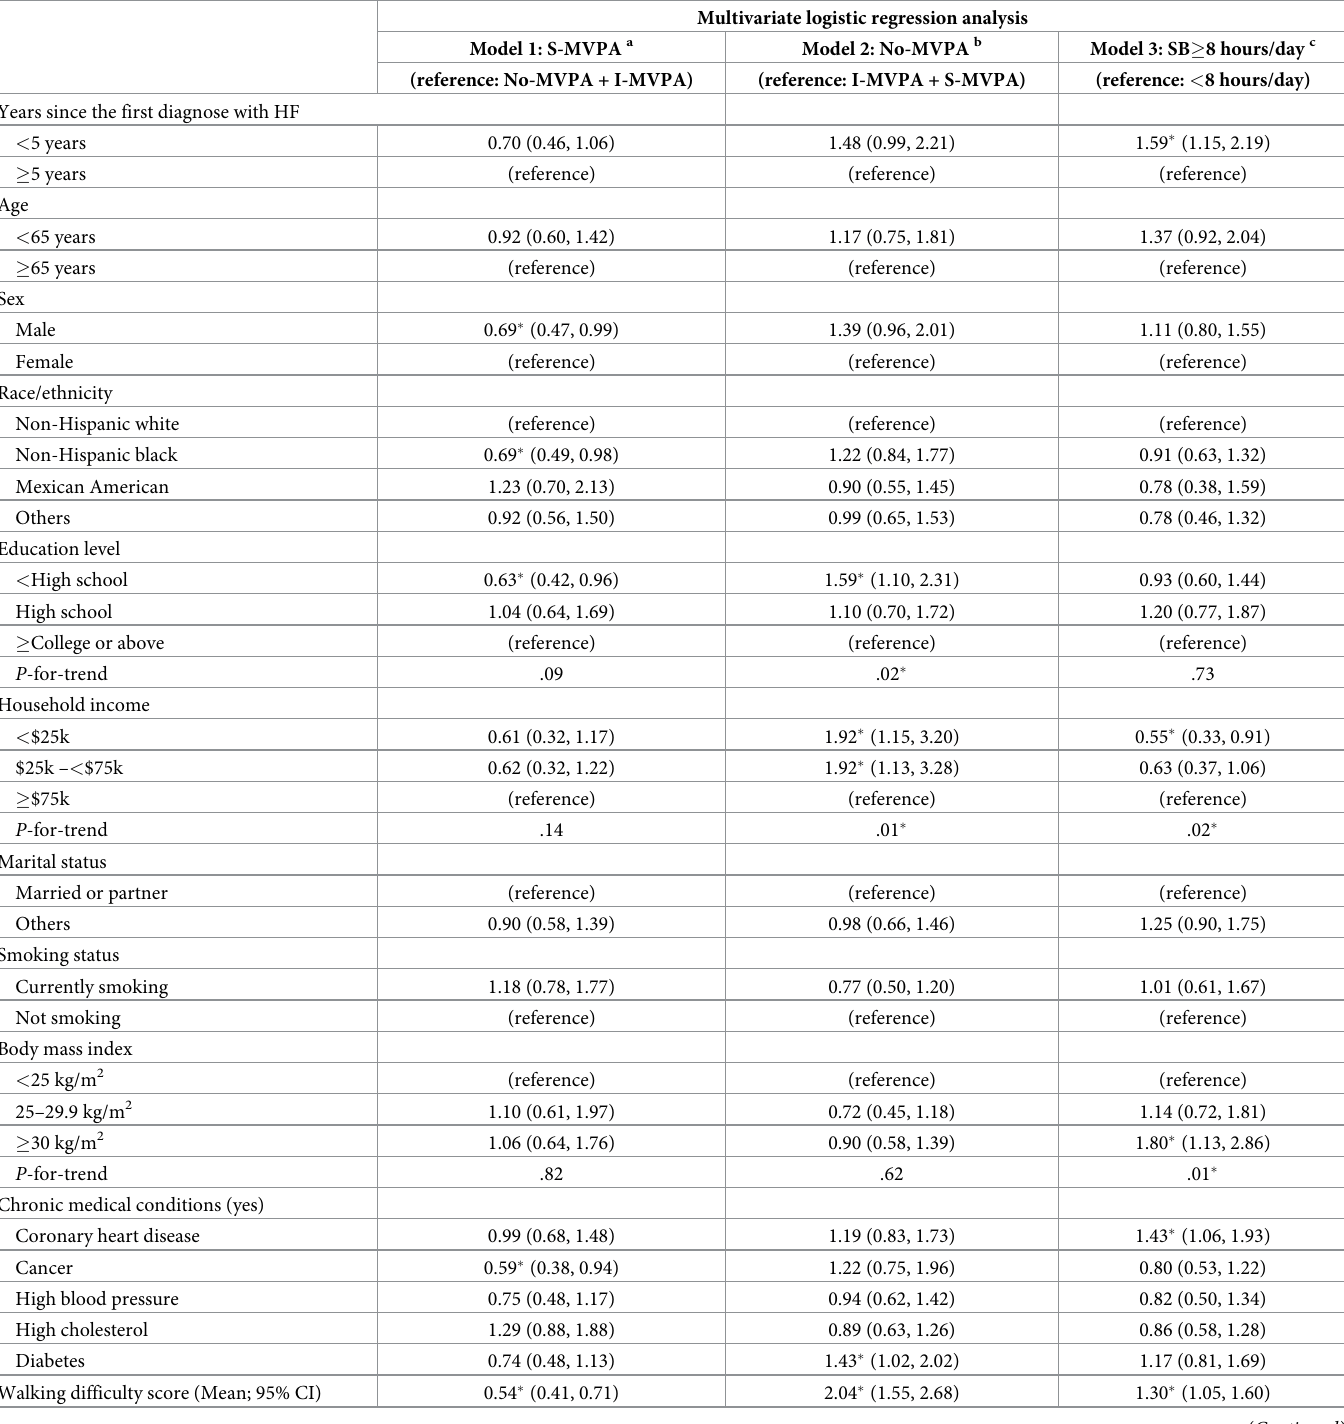
Table 3. The correlates of MVPA and sedentary behavior among adults with a history of congestive heart failure (NHANES 2007–2018). Multivariate logistic regression